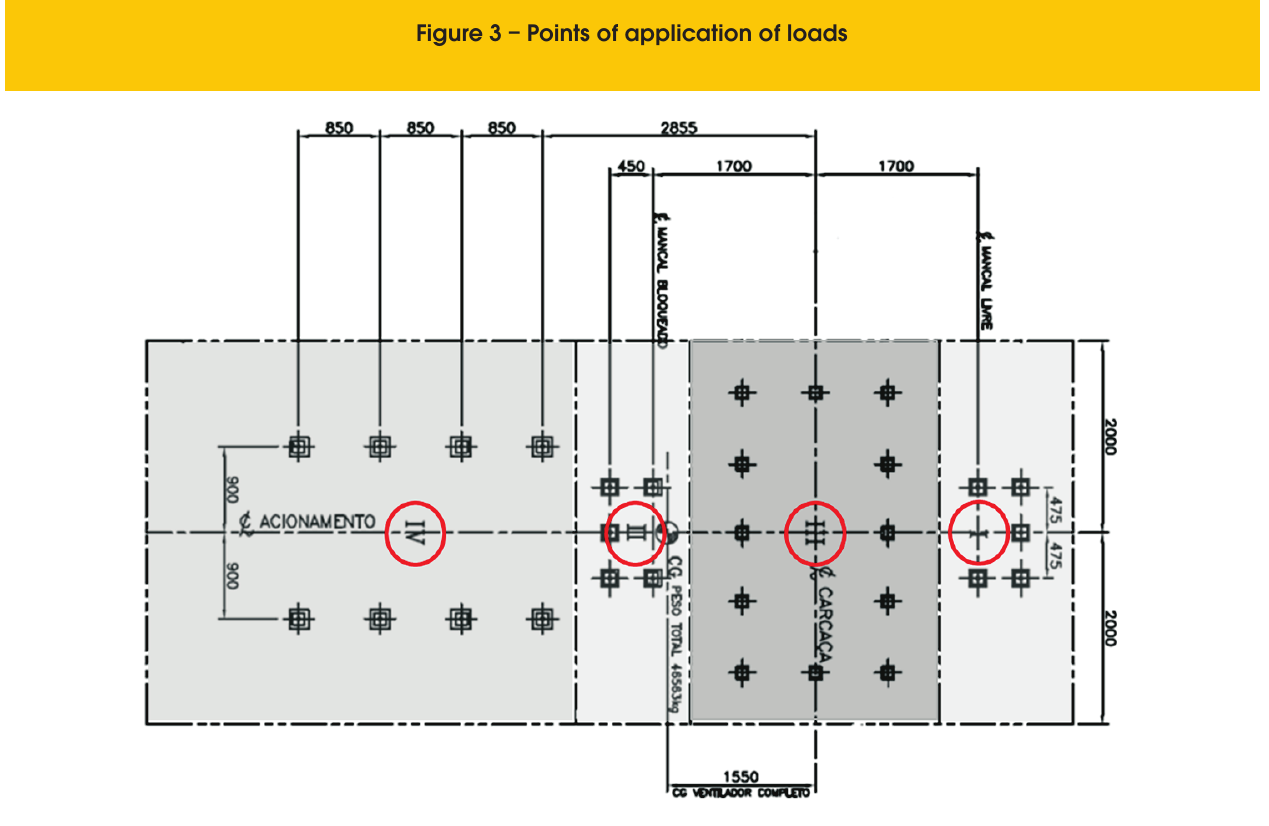
Figure 3 – Points of application of